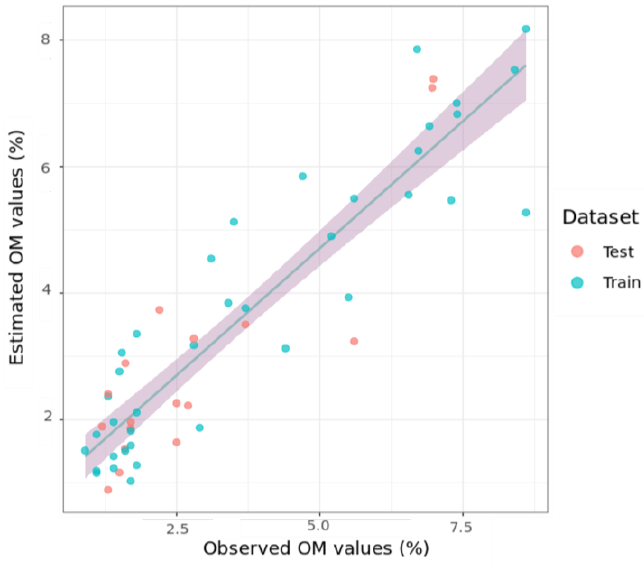
Figure 8. Scatter plot of the best fitted model (Cubist, absorbance, and Savitzky–Golay 1st derivative) for the OM prediction using HySpex data, including the regression line (blue) with the 95% confidence interval (grey).